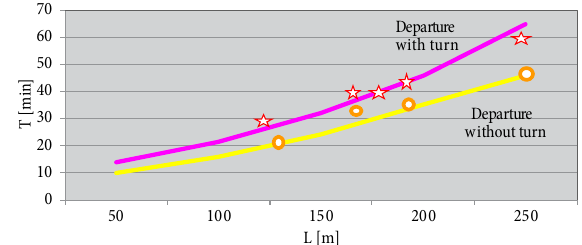
Fig. 10. Ship departure time from Malkų Bay, including and excluding a turn, depending on the ship’s length received using the calculation method and experimental data on real ships